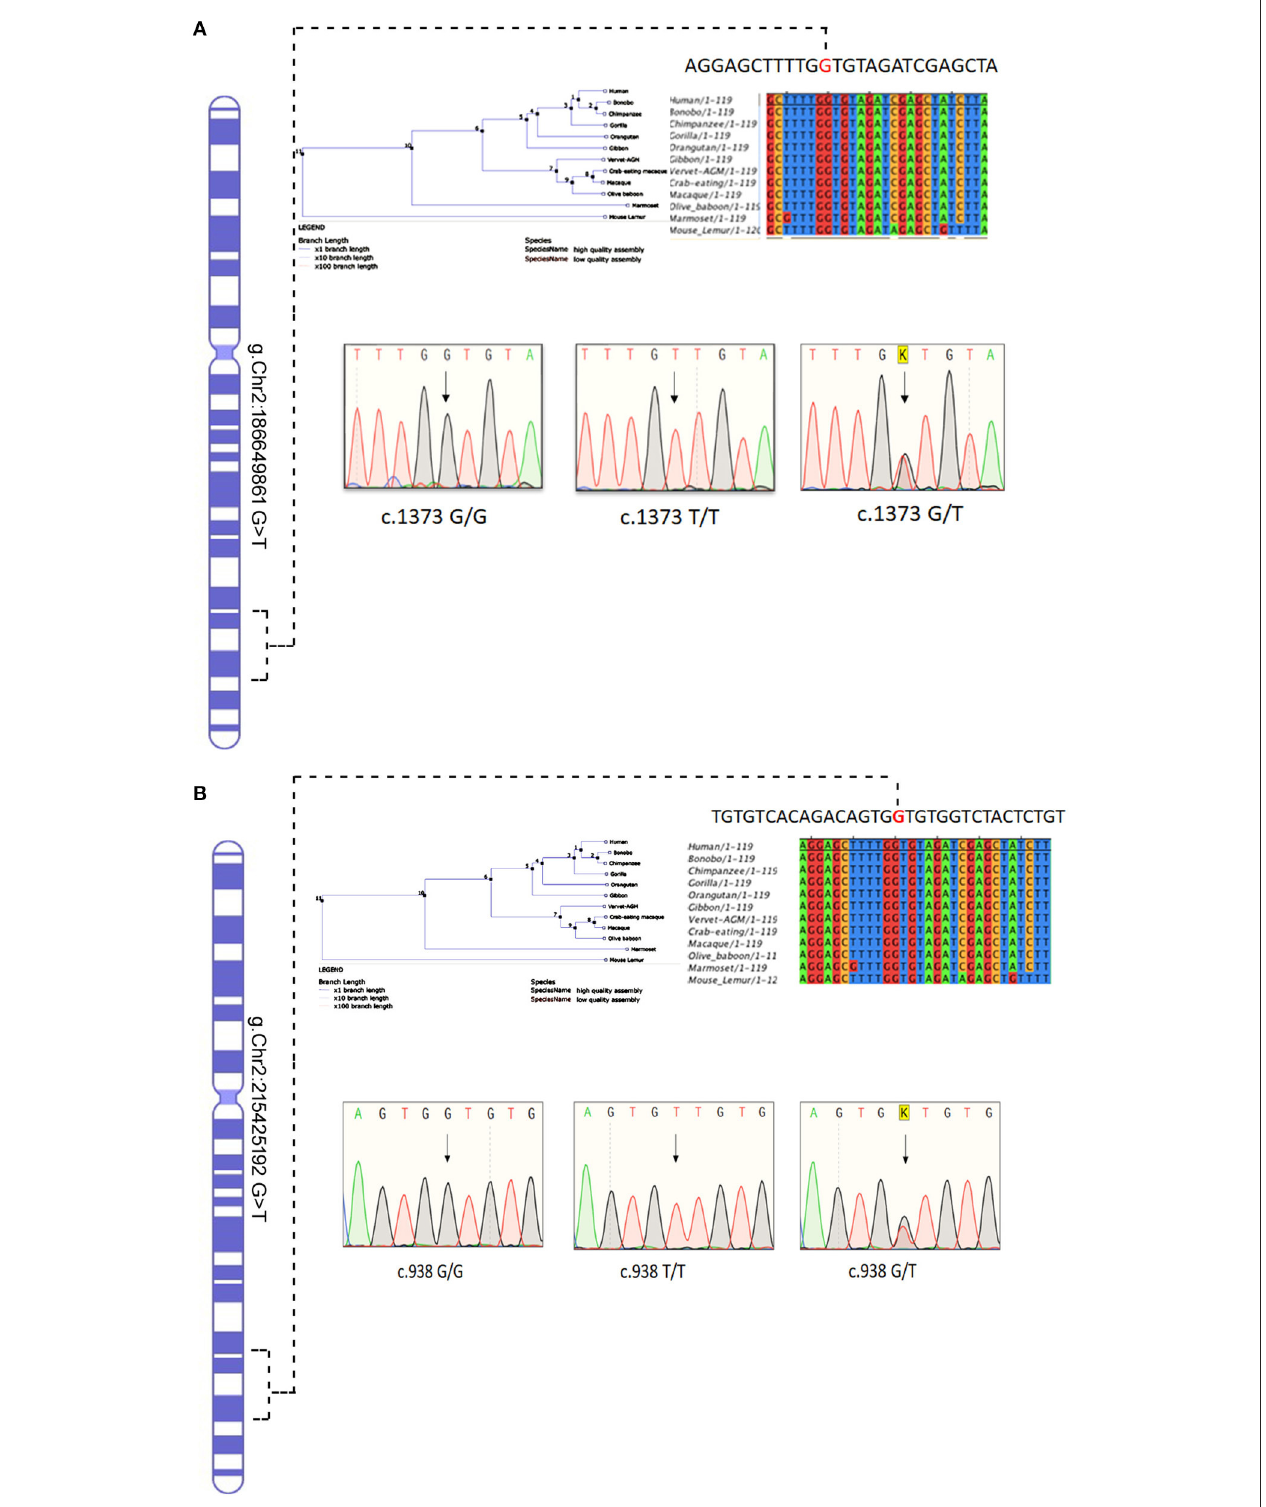
FIGURE 7 | Chromosomal location of human (A) ITGAV and (B) FN1 genes in chromosome 2 and chromatograms of both missense mutation sequence (wild type, heterozygote, and homozygous mutant genotypes) observed in the family. The twins are homozygous for both mutations ITGAV (c.1373G/G), FN1 (c.938 G/G). Parents are heterozygous for both mutations. Nucleotide sequence Alignment and phylogenetic tree of human ITGAV and FN1 genes.